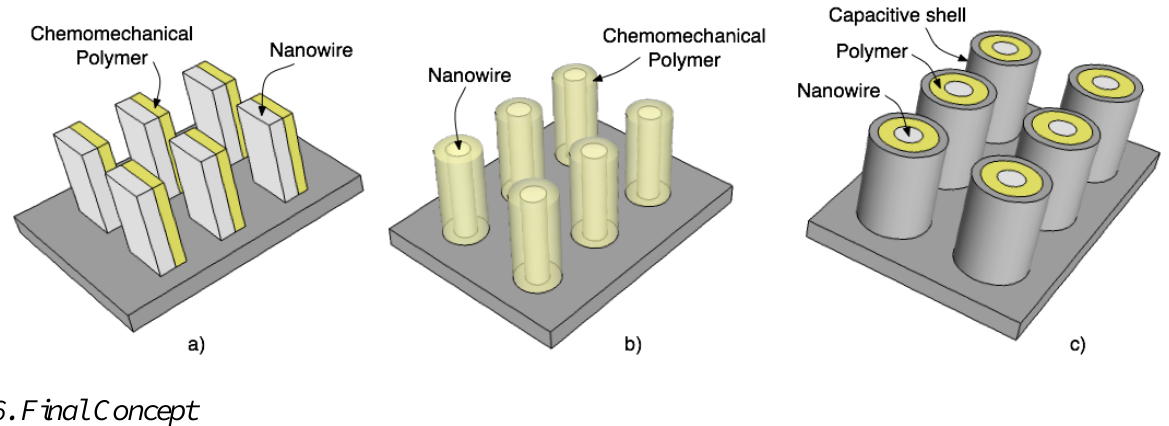
Figure 8. Evolution of second concept variant inspired by troponin and